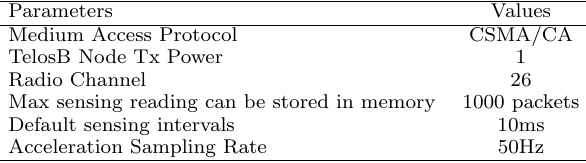
Table 1: The configuration of the node Parameters Values Medium Access